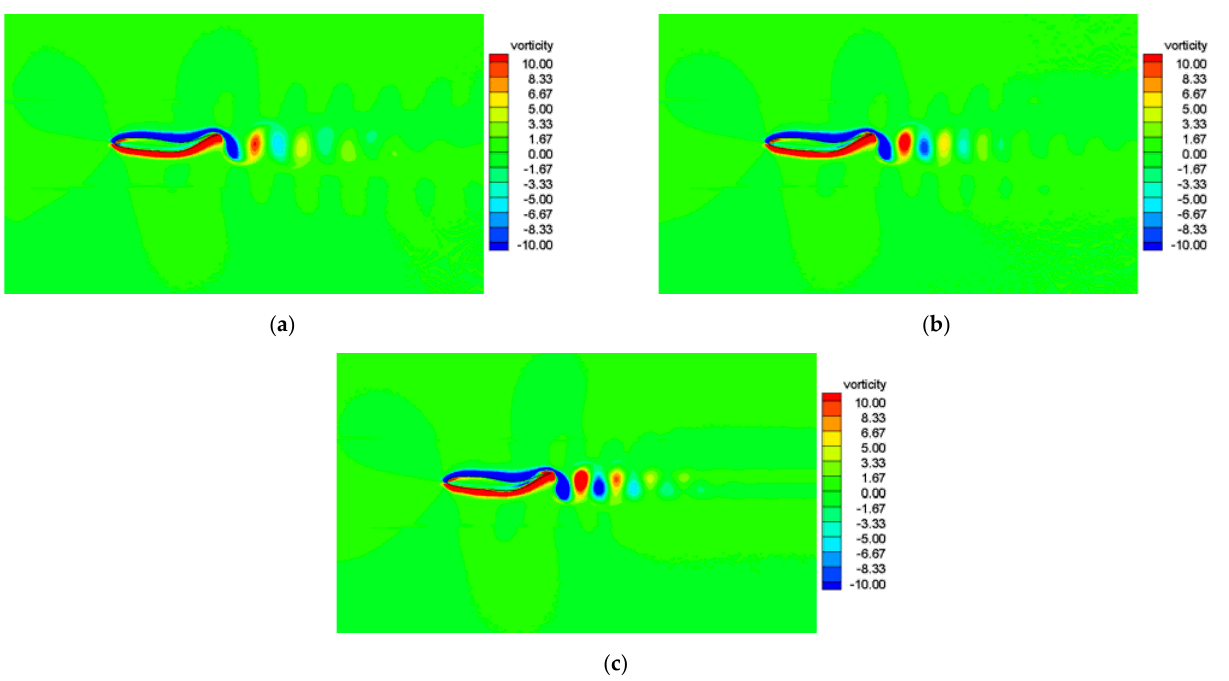
Figure 9. Contours of vorticity at different Reynolds numbers. ( a ) Re = 5000; ( b ) Re = 50,000; ( c ) Re = 500,000.